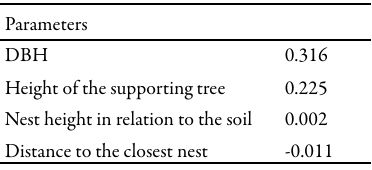
Table 2: Descriptive canonical correlation between the volume of Microcerotermes